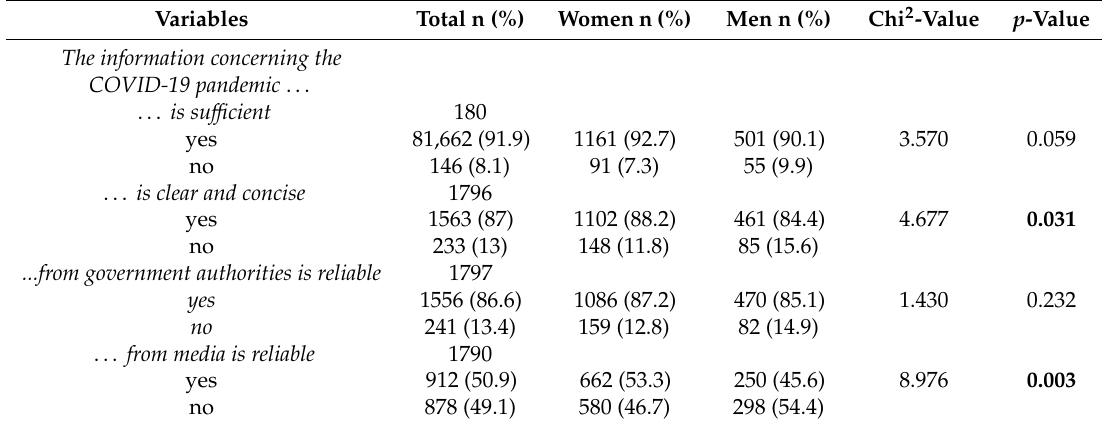
Table 2. Perception of information based on gender (number, percentage and Chi 2 -analysis).